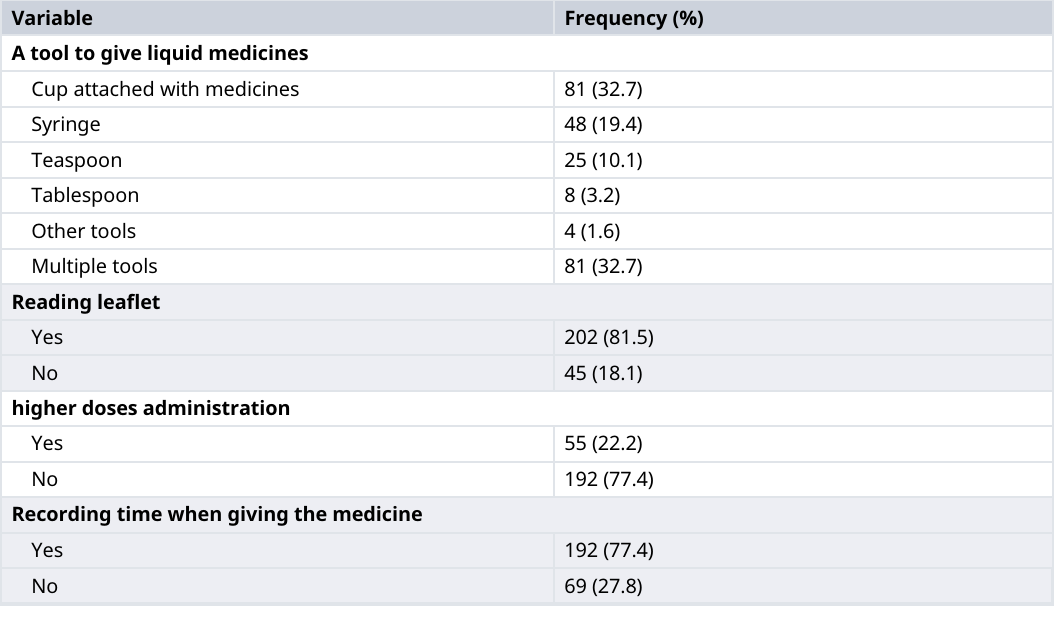
Table 4. Parents ’ practices during the administration of oral medicines ( N = 247).